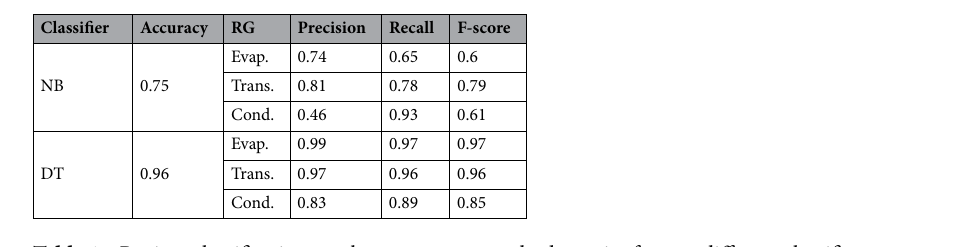
Table 1. Regime classification results on test set: standard metrics for two different